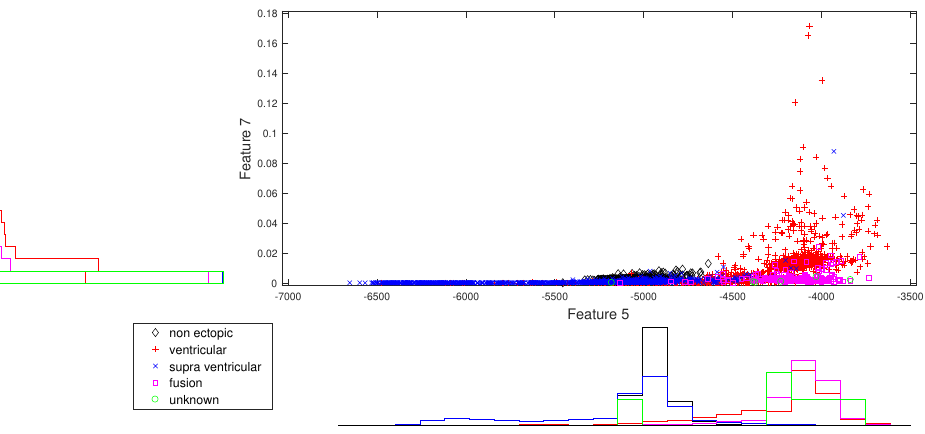
Figure 3. Scatter plot with marginal histogram for log entropy (IMF1) vs. CUM2